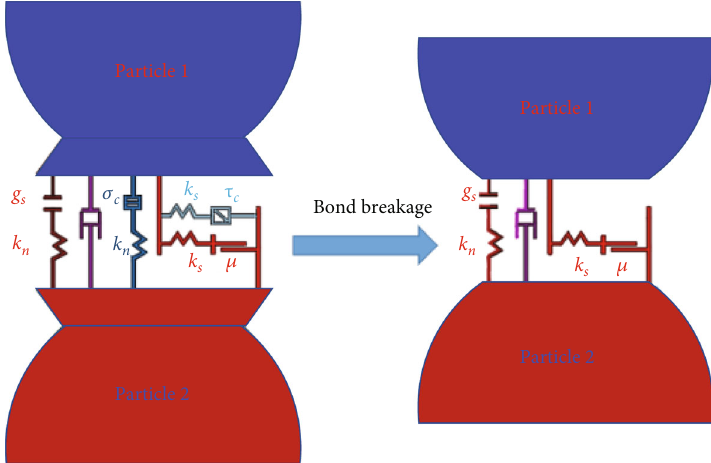
Figure 1: Parallel bond model in PFC 2D : (a) parallel bond; (b) bond